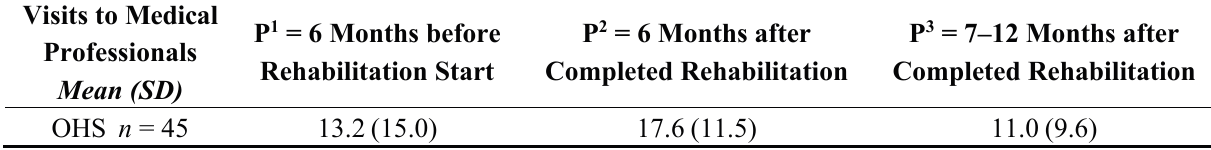
Table 9. Visits to medical professionals for the OHS group, displaying mean values and standard deviation (SD) for the measures during P1 1 , P2 2 , and P3 3